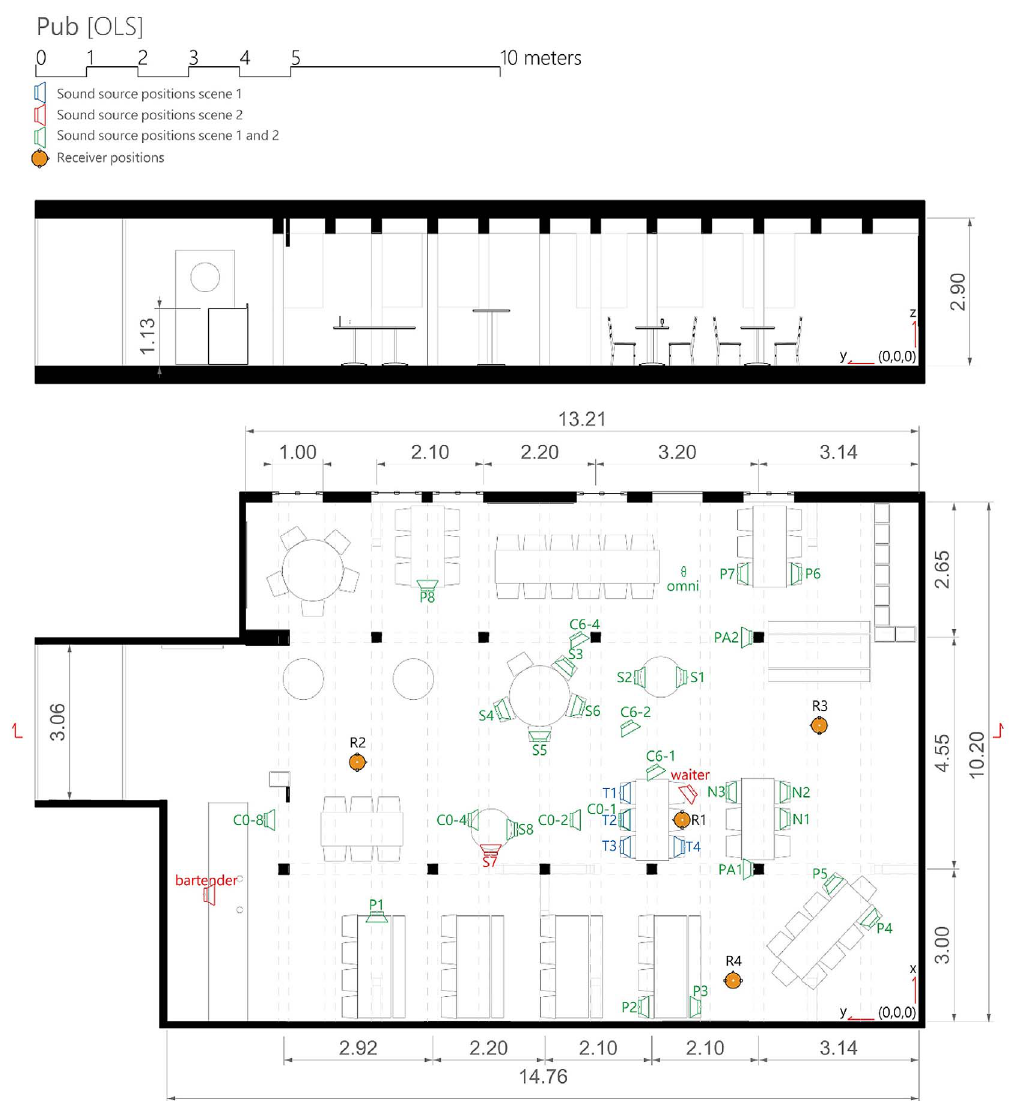
Figure 3. Cross section (top) and fl oorplan (bottom) of the pub environment in the same style as in Figure 2. Position and orientation in the horizontal plane of receivers (denoted with R1 to R4) is indicated by head symbols. Position and orientation of sources is indicated loudspeaker symbols. Sources indicated in blue belong to scene 1, sources indicated in red belong to scene 2. Here, T represents typical target sources at the table. Sources in green belong to both scenes. The letter N is used for sources at the neighbour table, which would typically be mostly intelligible, the letters S and P are used for sources further away. C refers to sources standing at various distances from R1. Furthermore, there are a bartender and waiter source, and an omni-directional source for measurements of room acoustic